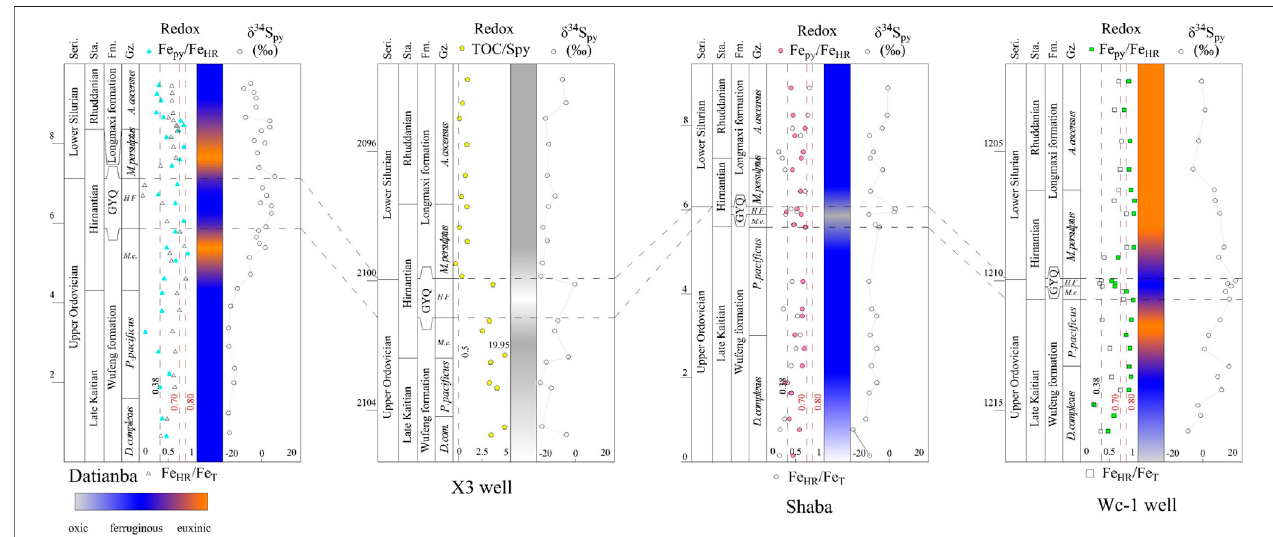
FIGURE7| Variations inFe py /Fe HR ,Fe HR /Fe T , δ 34 S py ,and TOC/S py intheKatiantoRhuddanian shales ofShabasectionand Wc-1wellinthestudyarea,Datianba section (Liu et al., 2016), and X3 well (Xi et al., 2021). The meaning of virtual lines and numbers in graph is consistent with Figure 2 .